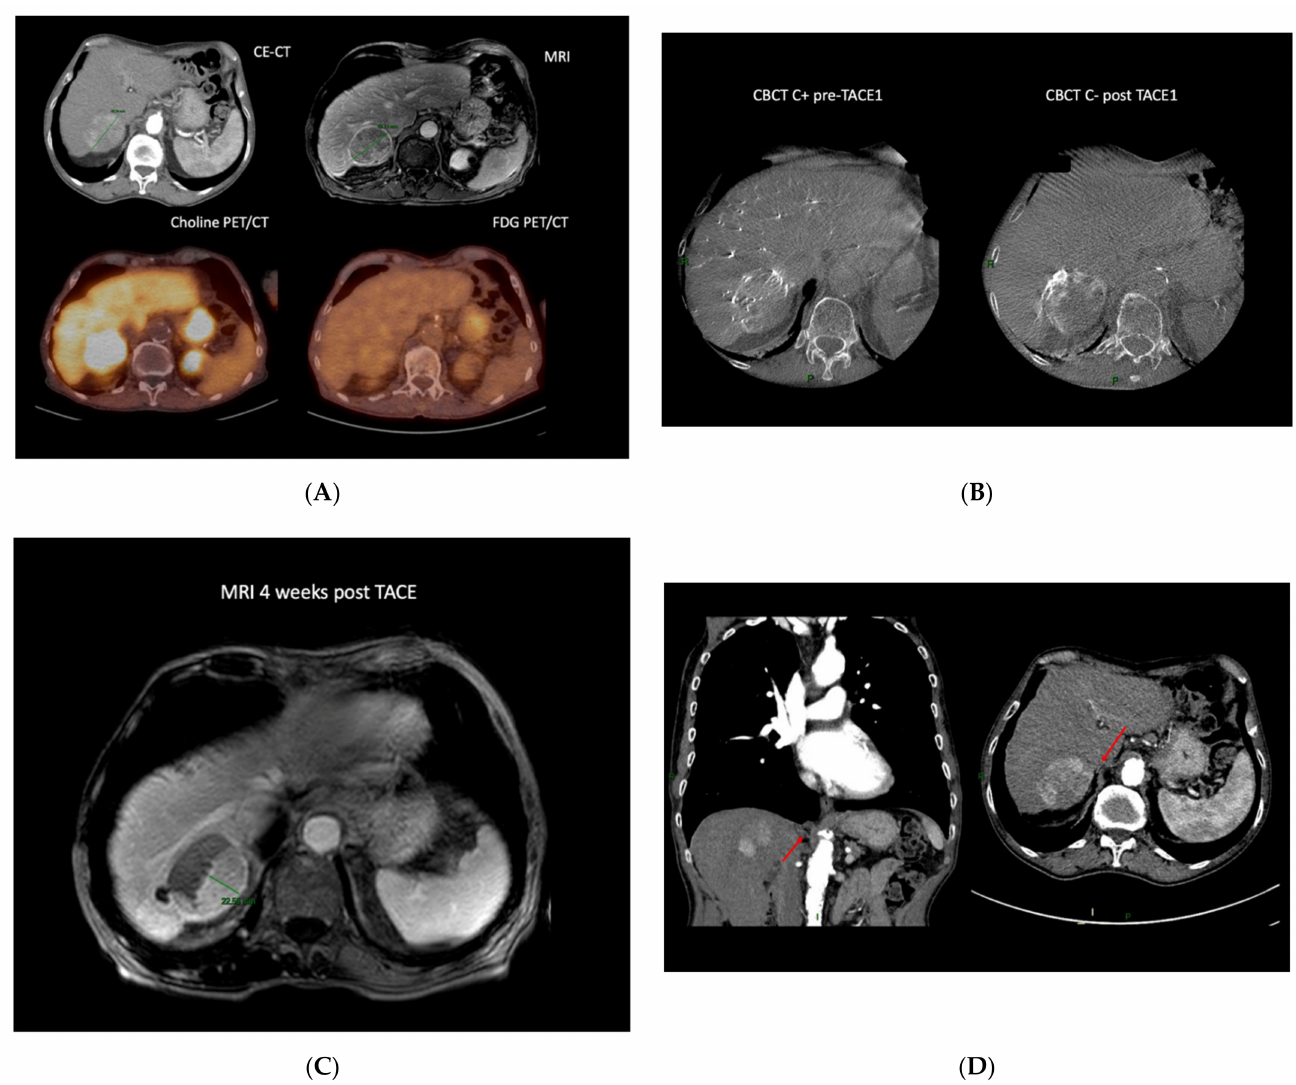
Figure 1. Case example of an 80-year-old patient diagnosed with a 62 mm HCC developed on cirrhosis (chronic hepatitis C). The work-up disclosed no distant metastasis. He underwent a double PET CT (FDG and choline) that showed a choline positive intake, suggesting a well-differentiated tumor ( A ). Due to multiple comorbidities, he could not undergo surgery; therefore, after a multidisciplinary discussion with the hepatic board, TACE was recommended. The enhanced CBCT performed before TACE showed sub-optimal treatment, with 30% of the lesion not being treated, which was confirmed on non-enhanced CBCT post DEM administration ( B ). The control MRI at 1 month showed a partial response with a 22.5 mm residual tumor ( C ). The patient had a CE-CT that showed a particular anatomy, with the non-responding side of the tumor being vascularized by a right phrenic artery ( D ). The patient underwent a second TACE, but unfortunately, the small artery could not be catheterized. Due to his general status, the patient benefited from BSC. (CE-CT: computed tomography; MRI: magnetic resonance imaging; Choline PET/CT: Choline positron emission tomography; FDG